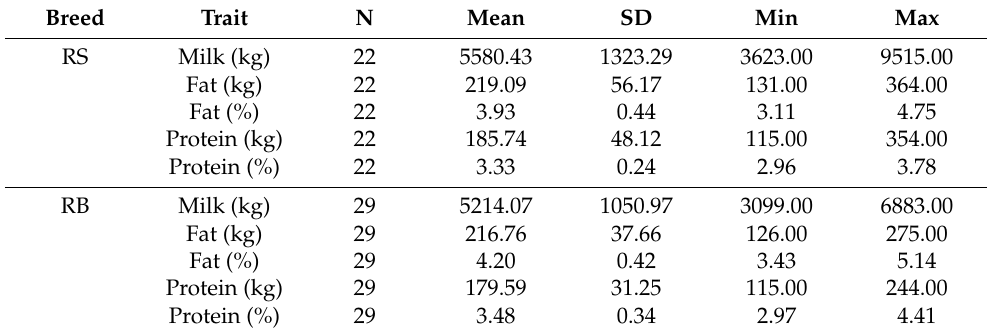
Table 2. Descriptive statistics for milk production and quality traits in Romanian dairy cattle.